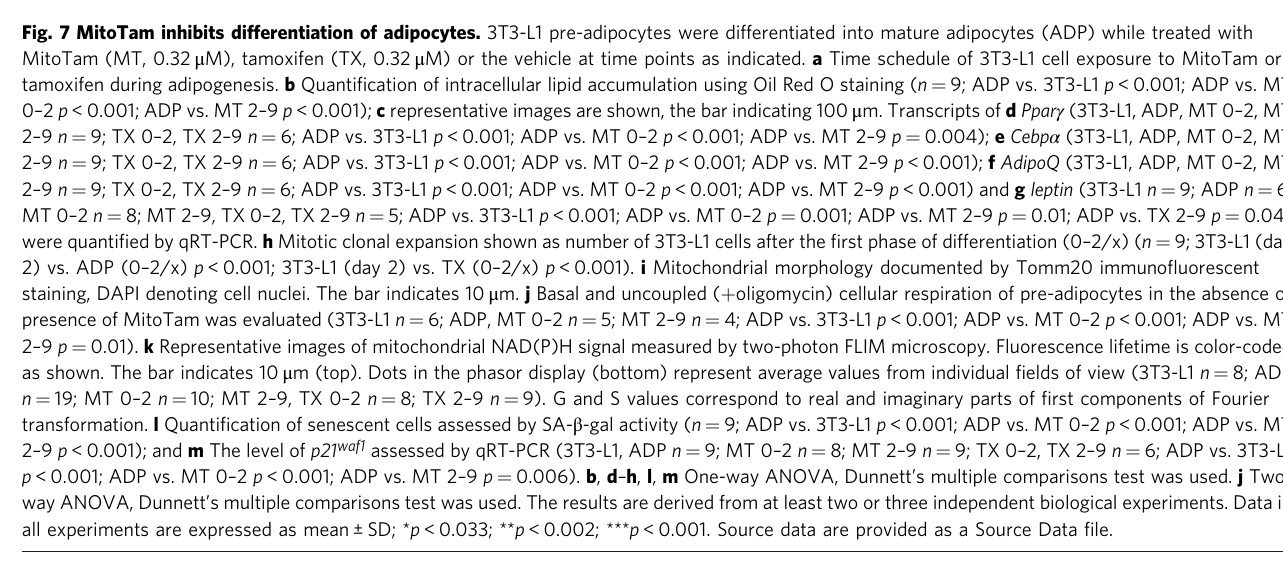
Fig. 7 MitoTam inhibits differentiation of adipocytes. 3T3-L1 pre-adipocytes were differentiated into mature adipocytes (ADP) while treated